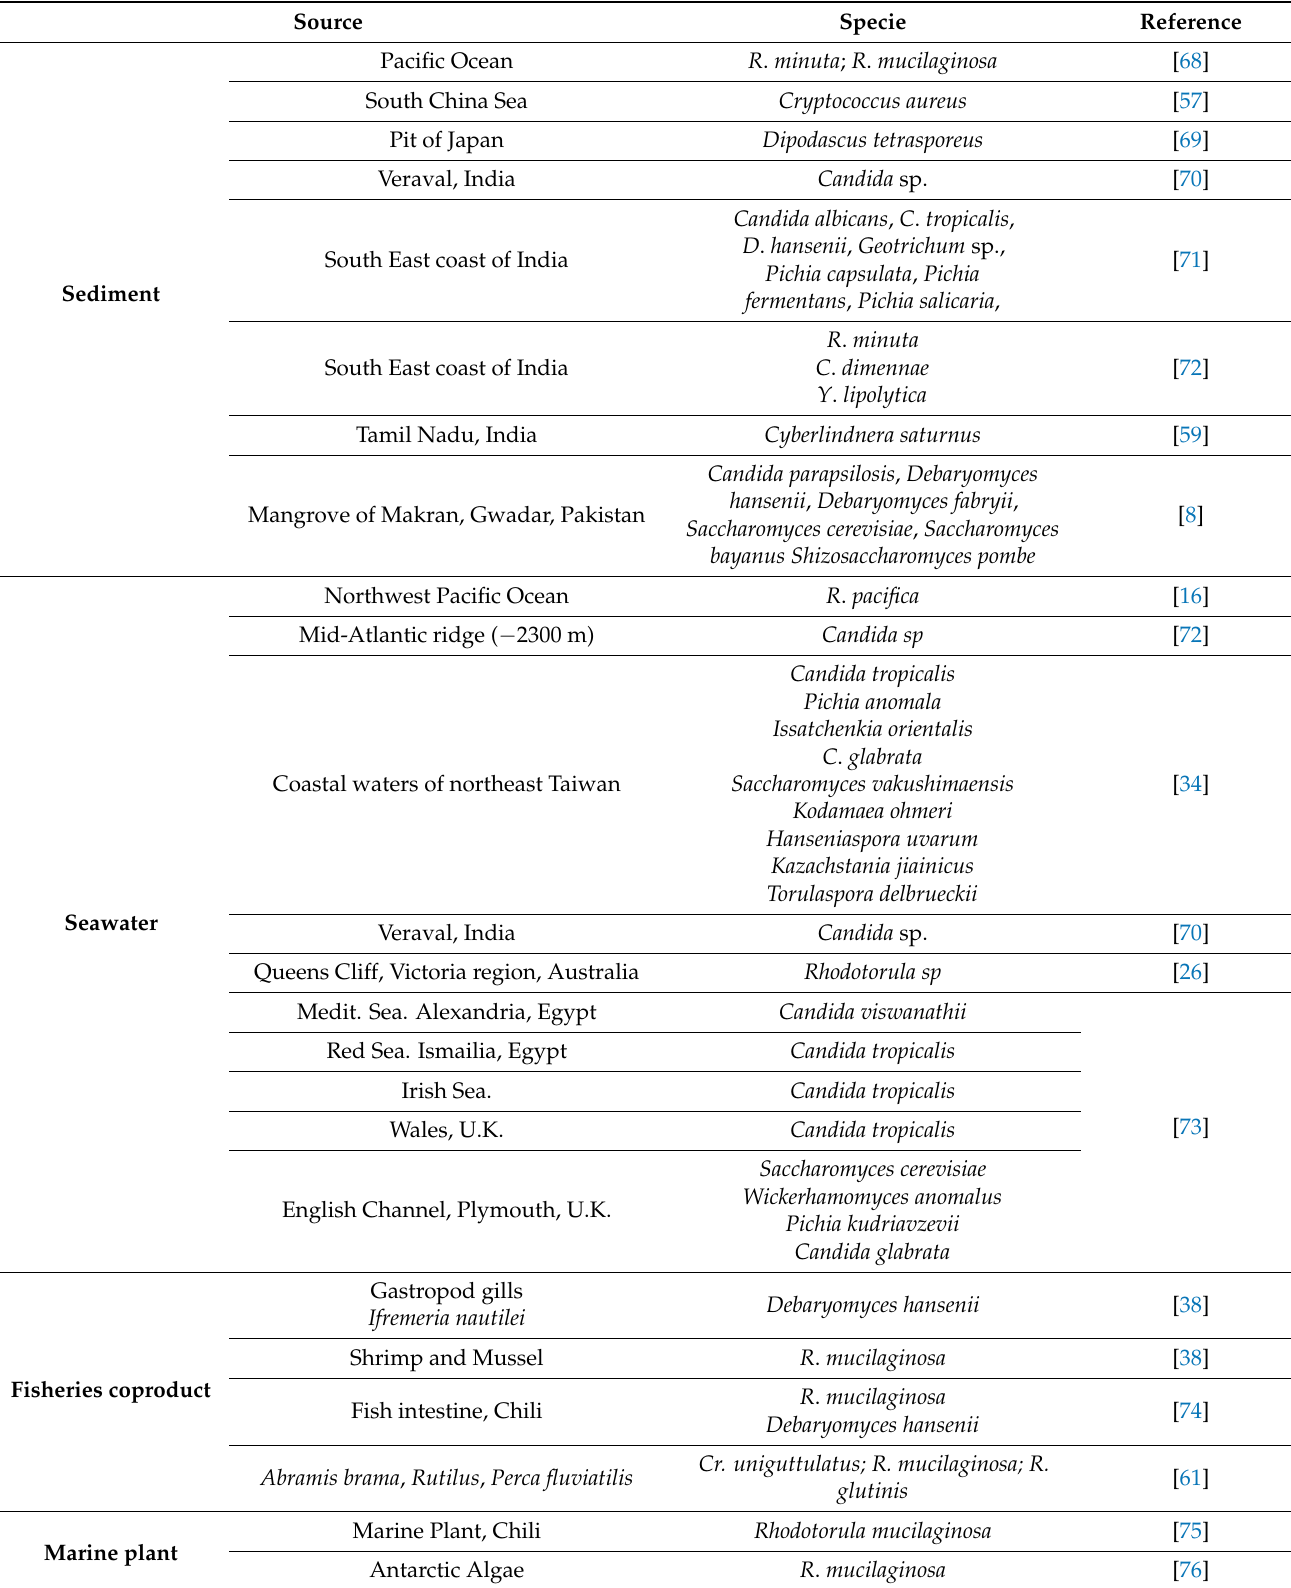
Table 4. Distribution of marine yeast species by source using transcription of the ITS and D1/D2